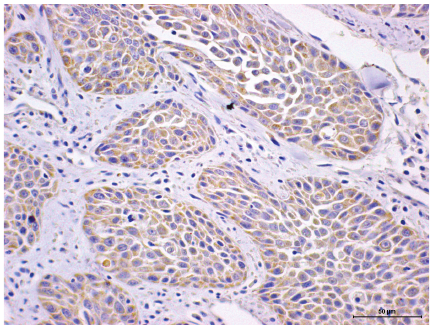
Figure 2: Immunolocalization of AE1/AE3 in nasal carcinoma. Positive signal can be observed as the brown color in the cytoplasm of the cells or in the cytoplasm with hematoxylin counterstain. Bar = 200 𝜇 m.